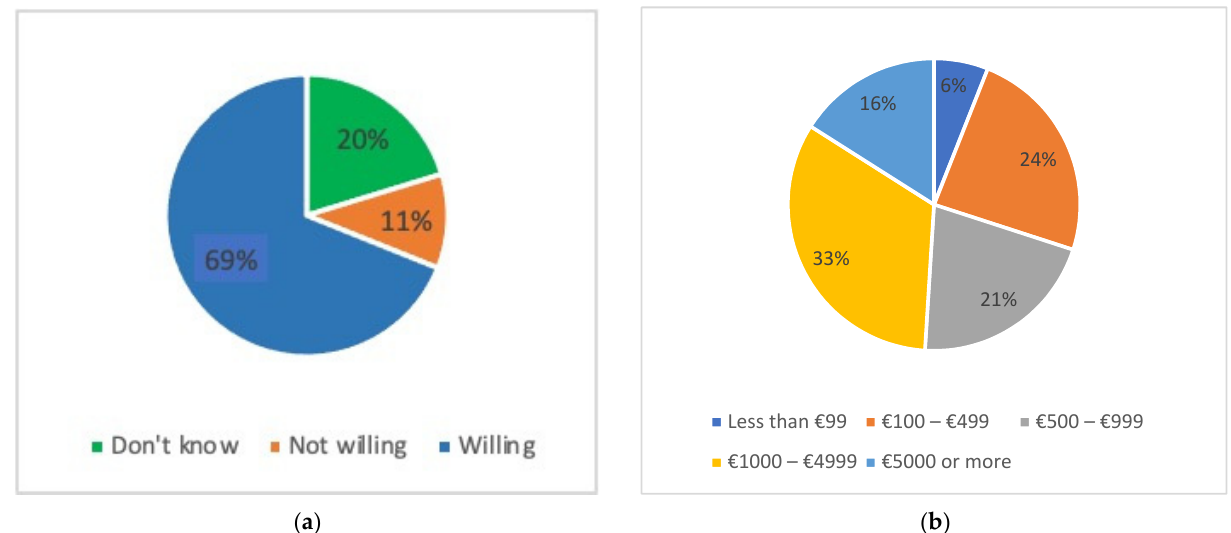
Figure 9. ( a ) Willingness to pay for SG technologies in Carloforte; ( b ) Range of payments respondents are willing to make in Carloforte.